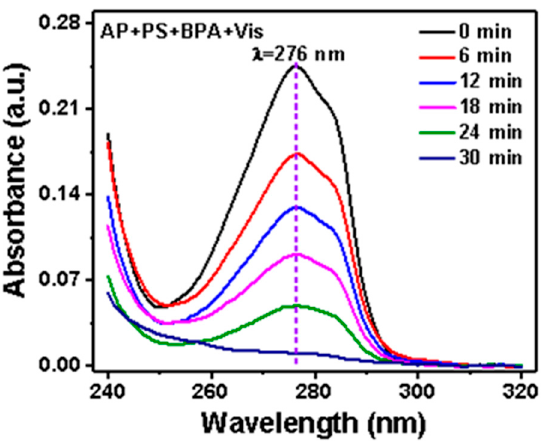
Figure 6. UV-visible absorption spectra of time-dependent bisphenol A with Ag 3 PO 4 and potassium persulfate as photocatalysts under visible light irradiation.